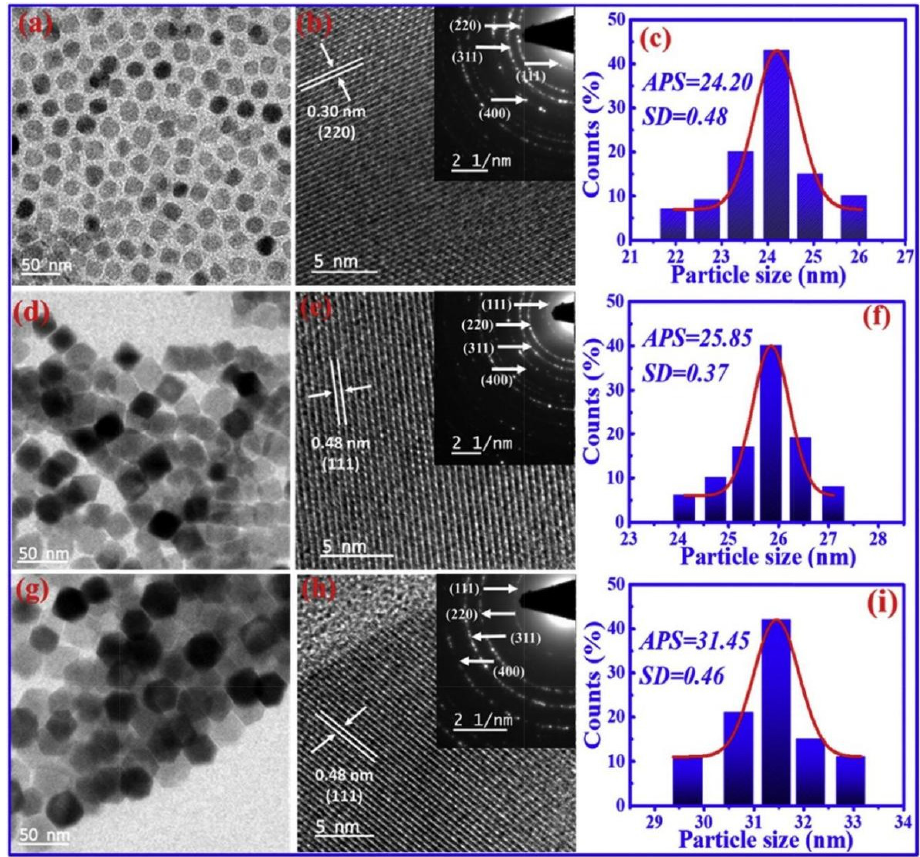
Figure 6. TEM, HRTEM micrograph and size distribution of ( a – c ) sphere-CoFe 2 O 4 ( d – f ) cubic-CoFe 2 O, and ( g – i ) hexagonal-CoFe 2 O. Reproduced with permission from [63] Copyright (2019) Else- vier. Table 1. Saturation magnetization, coercivity and K1 values of spherical, cubical and hexagonal shaped Co-ferrites [63] .